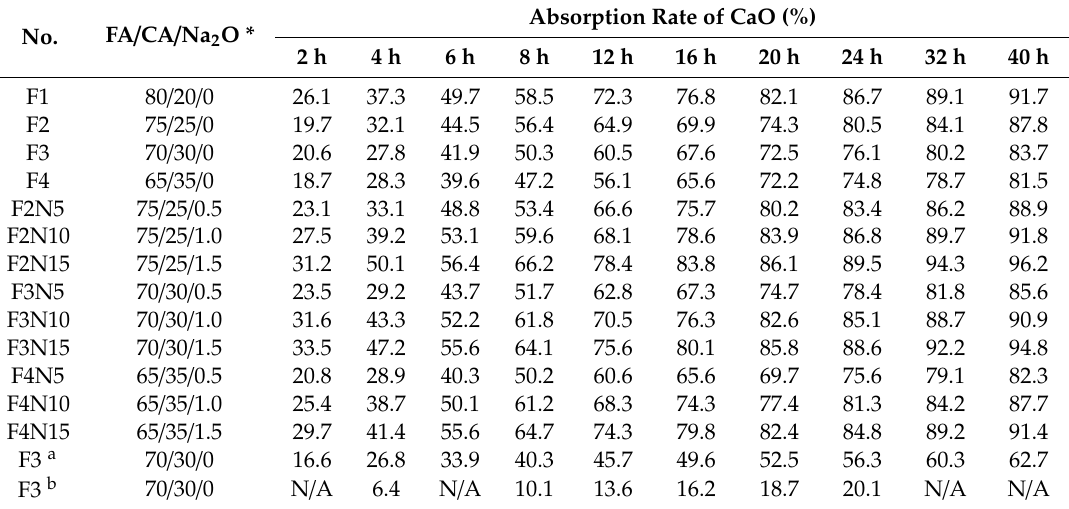
Table 2. CaO absorbed rate of precursors in the hydration reaction at 97 ◦